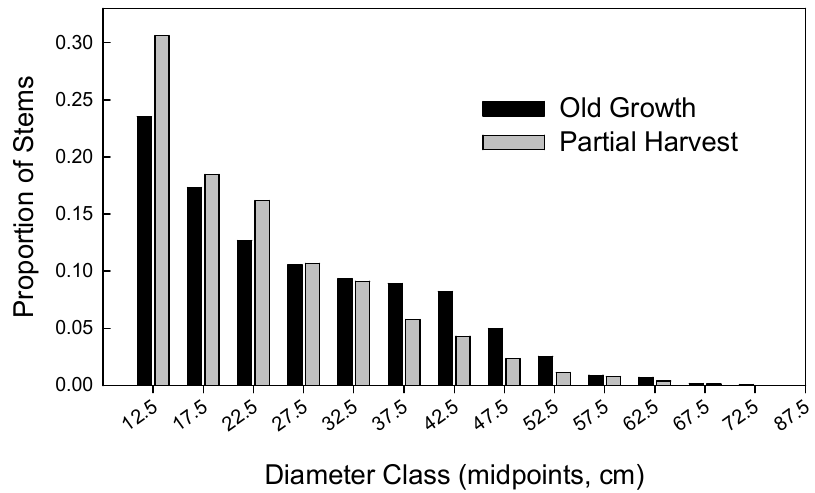
Figure 3. Diameter distributions of old-growth and partially harvested white-cedar stands (pooled